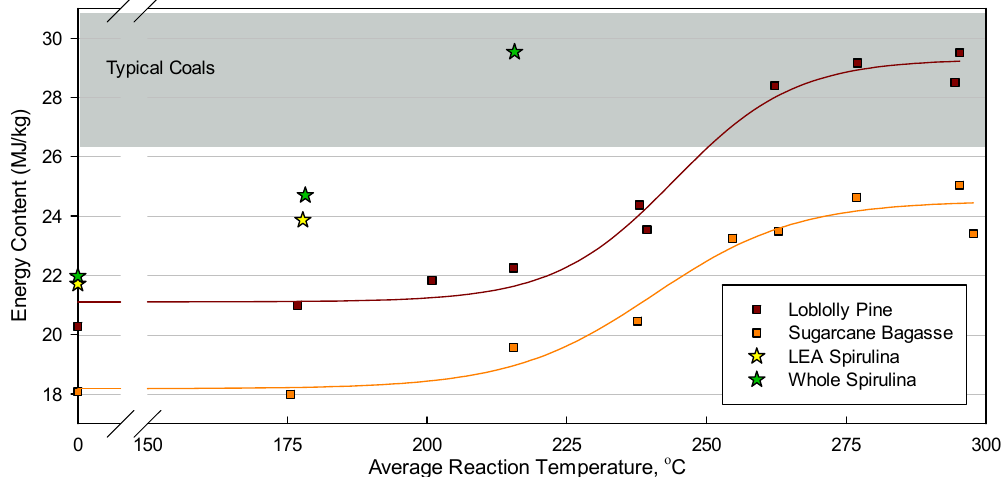
Figure 3. Energy densification of algal feedstocks (stars) in comparison to lignocellulosic feedstocks at various reaction temperatures and 30 min hold times. Lignocellulosic data from [23].